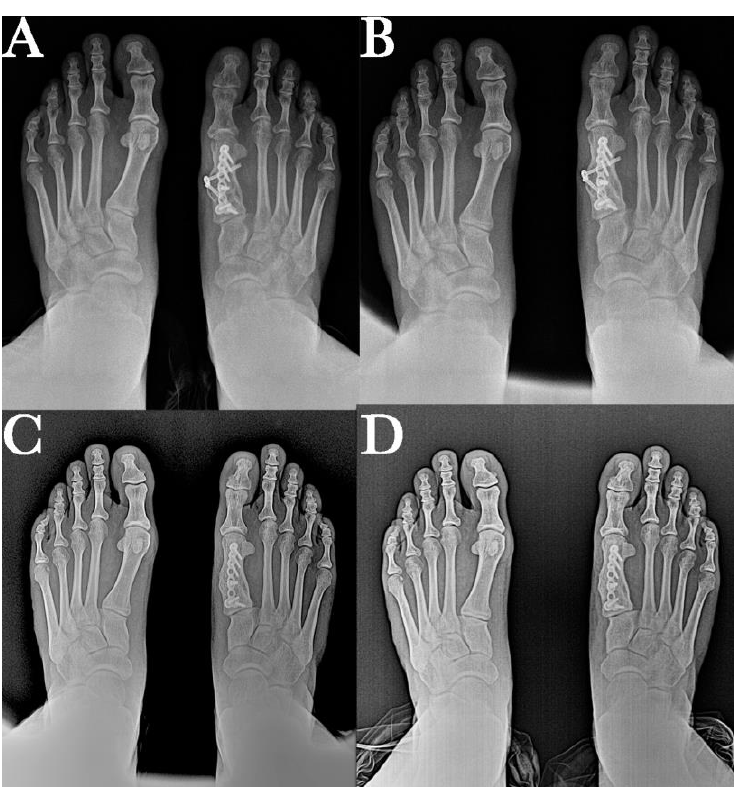
Figure 4. Correct position of the first metatarsal in the sagittal plane at ( A ) 6-month, ( B ) 12-month, ( C ) 18-month, and ( D ) and final 24-month follow-up after surgery, showing bone callus consolidation and remodeling, and maintaining correction of the analyzed radiographic parameters.